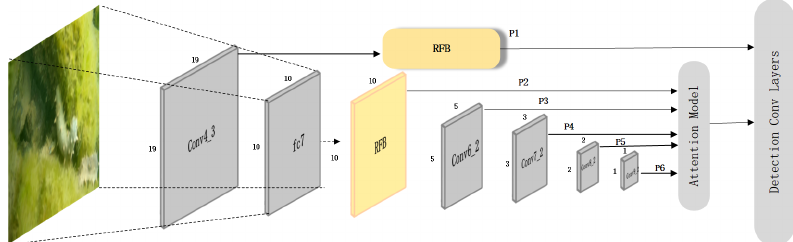
Figure 9. Improved SSD network